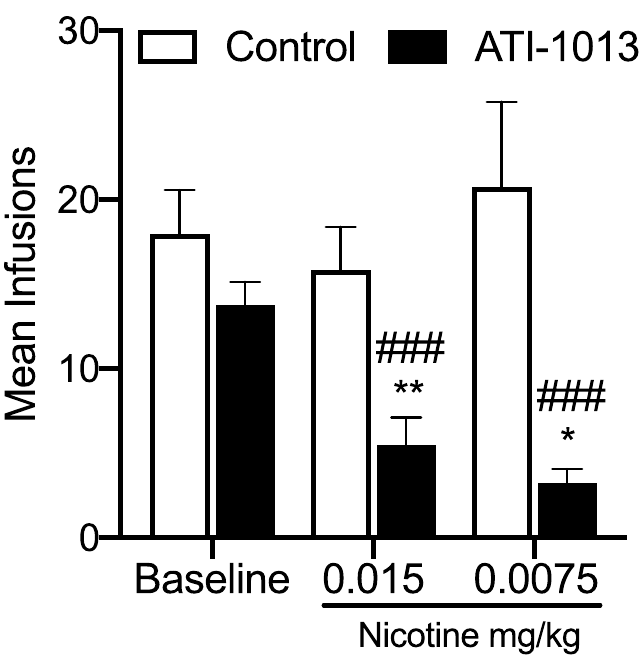
Fig 6. Nicotine self-administration in rats treated with ATI-1013. Mean infusions (n = 7/group) during the last three sessions of baseline (0.015 mg/kg unit dose, prior to nic•mAb treatment) and the last three sessions at each unit nicotine dose during twice-weekly (Monday and Thursdays) nic•mAb treatment. Sessions were 2 h in duration. Open bars represent data from rats treated with the nonspecific mAb Gammagard (160 mg/kg i.v.). Closed bars represent data from rats treated with ATI-1013 (160 mg/kg i.v.). ## p < 0.01 and ### p < 0.001 significantly different from baseline. � p < 0.05 and �� p < 001 significantly different from control. Data are expressed as mean ±